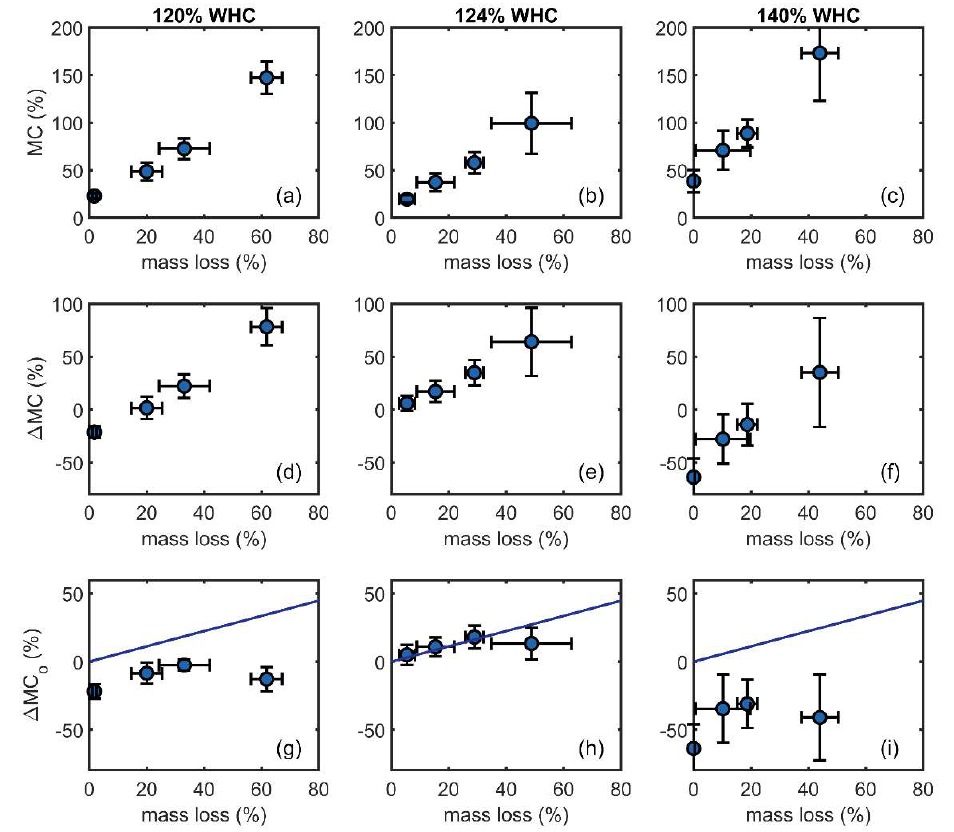
Figure 5. Relationship between mass loss and the moisture content at the end of the experiment calculated three di ff erent ways from Equations (3), (5), and (6) in rows 1, 2, and 3. The columns represent di ff erent soil water holding capacities. The error bars represent the standard deviation from five replicates.